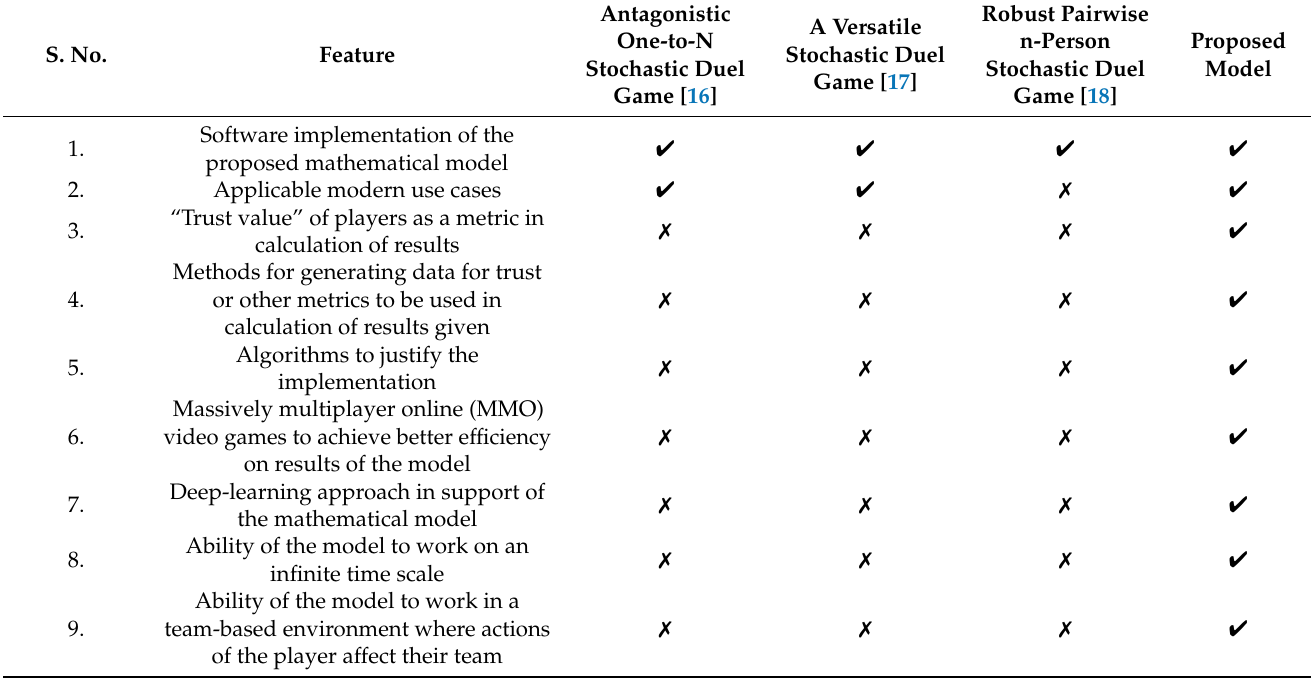
Table 2. Comparison of the proposed model with previously published